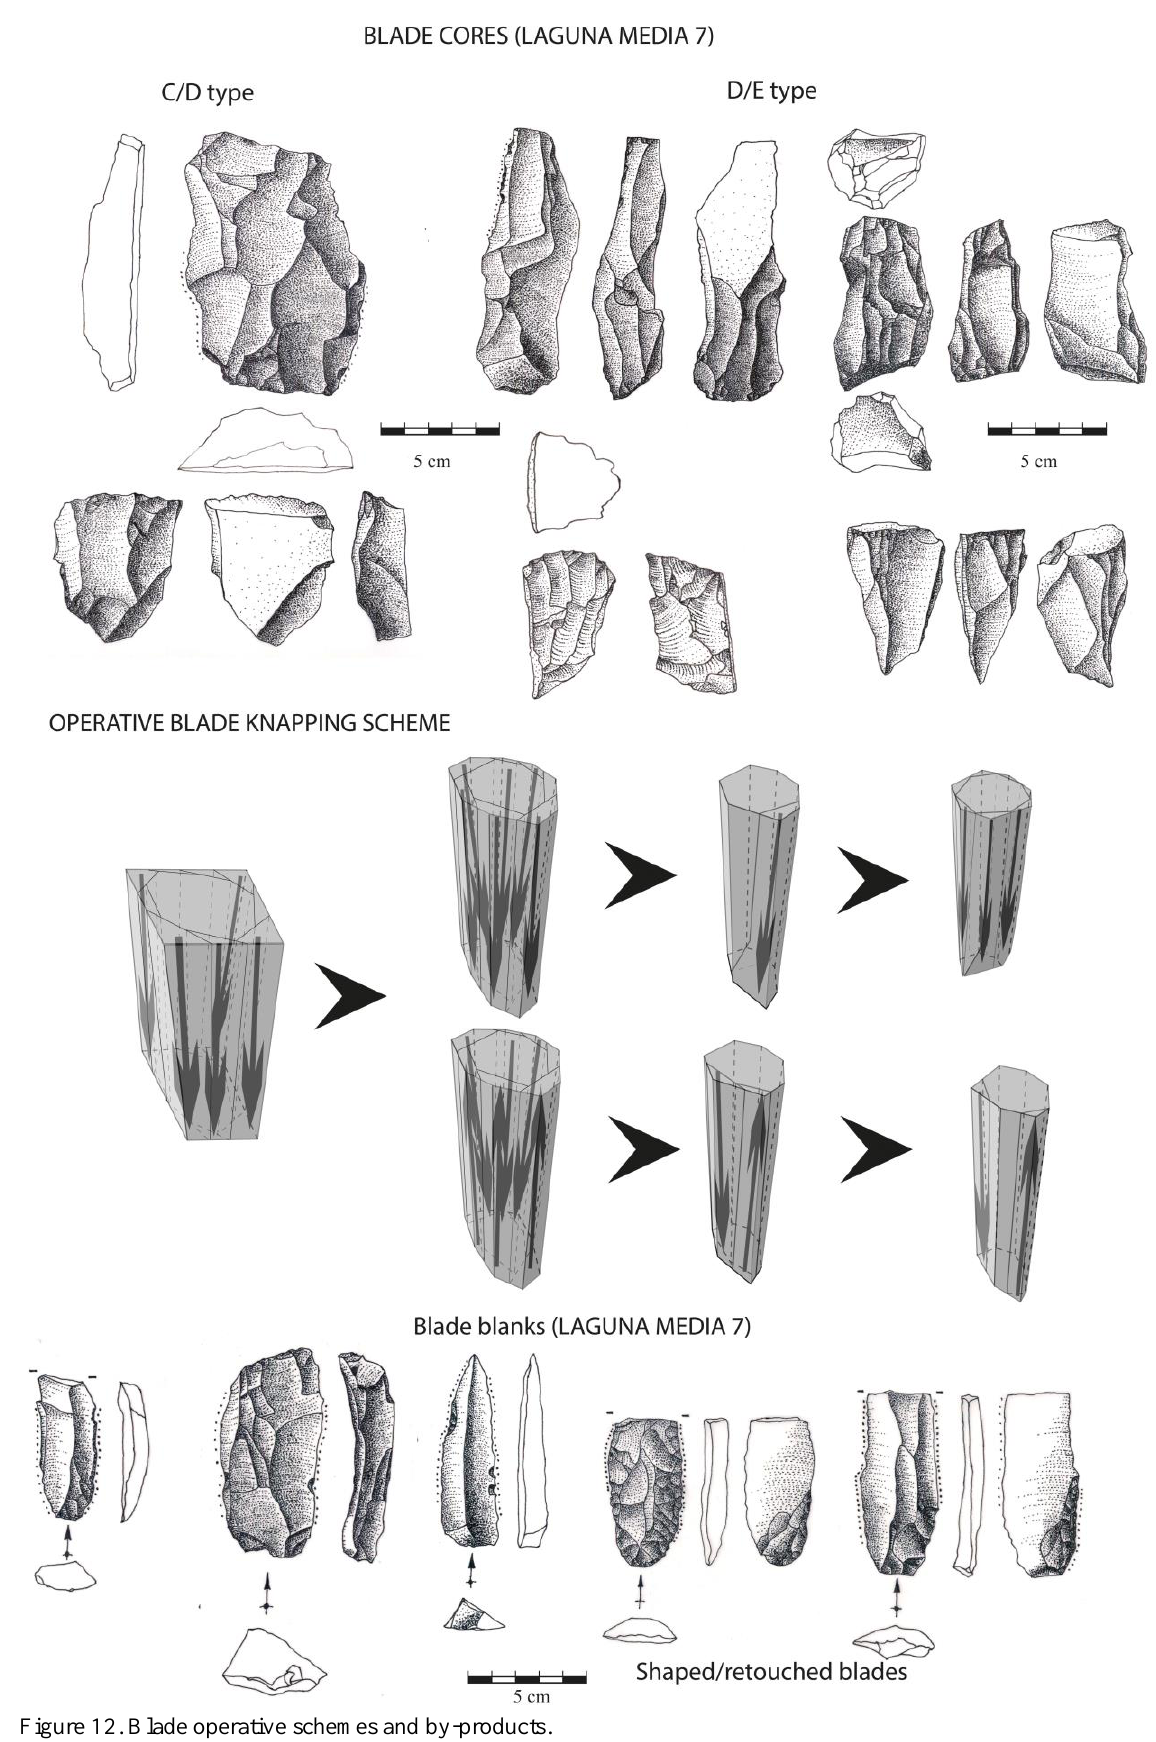
Figure 12. Blade operative schemes and